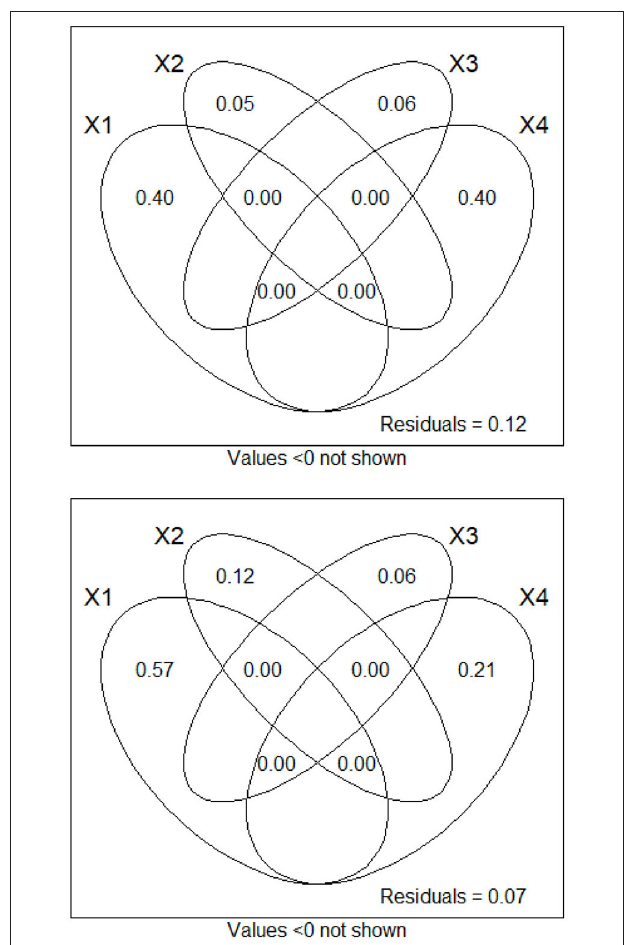
FIGURE 6 | Variation partition diagram of daily chlorophyll a and phycocyanin flurorometry between the four sets of dbMEM variables, as divided into ecologically interesting groups. See text for variable group explanations and